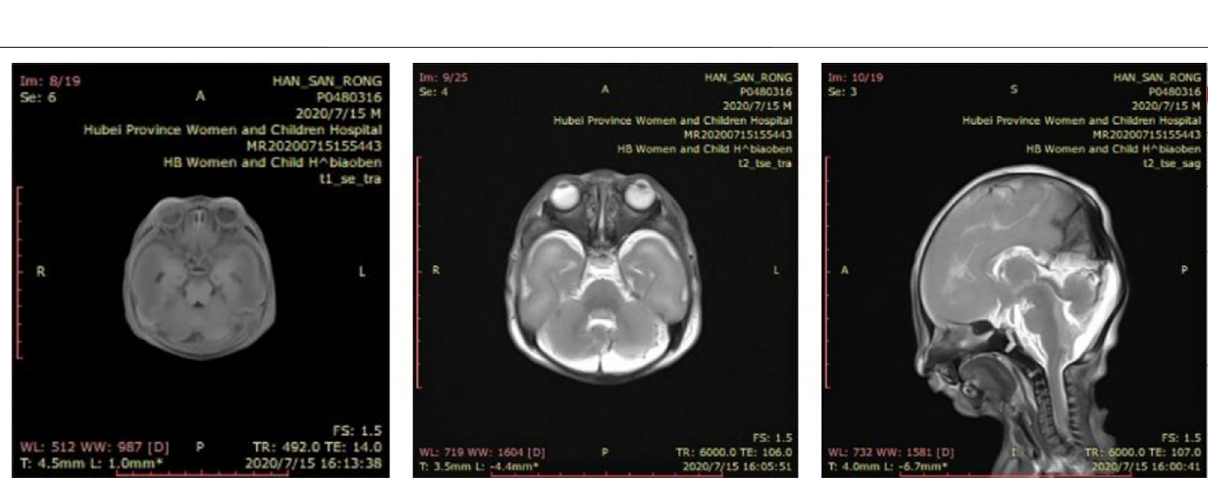
FIGURE 3 | The c.1113_1119del variant in RBM10 of this family. (A) The reference sequence (B) Proband (hemizygote) (C) Mother (heterozygote) (D) Father.